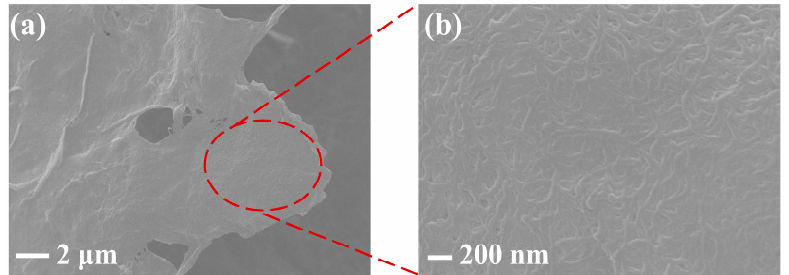
Figure 2. ( a ) SEM images of pure ANFs; ( b ) the magnified SEM image of pure ANFs.